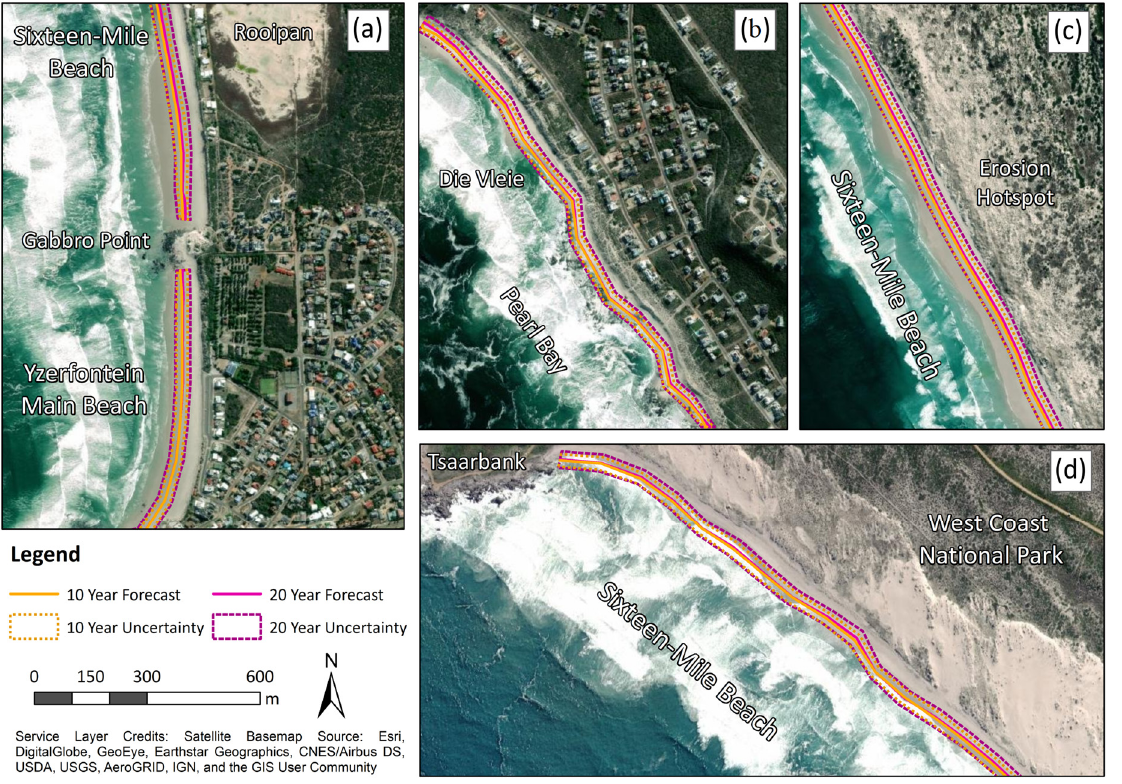
Figure 8. Shoreline position forecasts for the next 10 and 20 years with their horizontal uncertainty for four locations along the study site: ( a ) Yzerfontein Main Beach and the southern end of Sixteen Mile, ( b ) the northern end of Pearl Bay, ( c ) the erosion hotspot located 6 km north of Gabbro Point, and ( d ) the northern end of Sixteen Mile Beach at Tsaarbank.